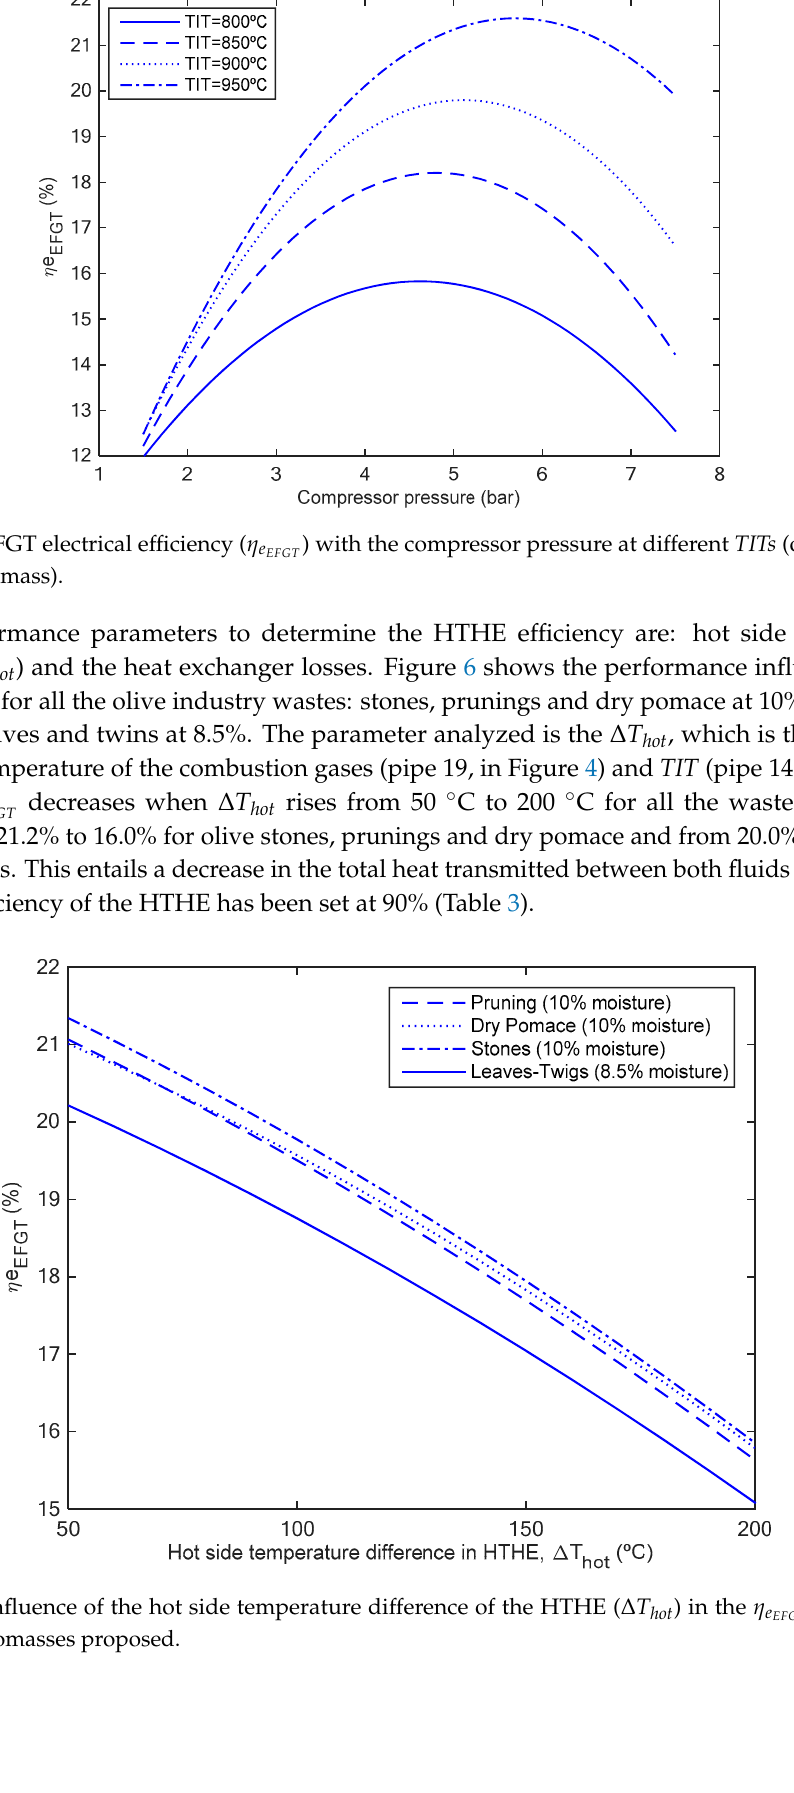
for the EFGT for the (cid:3254)(cid:3255)(cid:3256)(cid:3269)